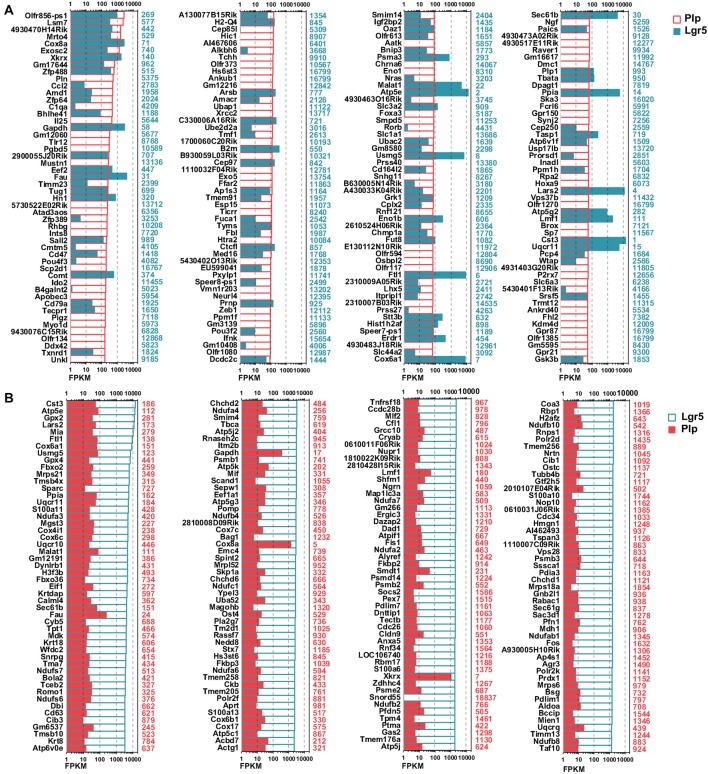
Top expressed genes in Lgr5+ and Plp1+ SCs. (A) The expression levels of the top 200 genes in Plp1+ SCs in descending order. The length of the bar after each gene represents its Fragments Per Kilobase of transcript per Million fragments mapped (FPKM) value. The numbers on the right side of each panel represent the rankings of the same genes in Lgr5+ SCs. (B) The expression levels of the top 200 genes in Lgr5+ SCs in descending order. The length of the bar after each gene represents its FPKM value. The numbers on the right side of each panel represent the rankings of the same genes in Plp1+ SCs.